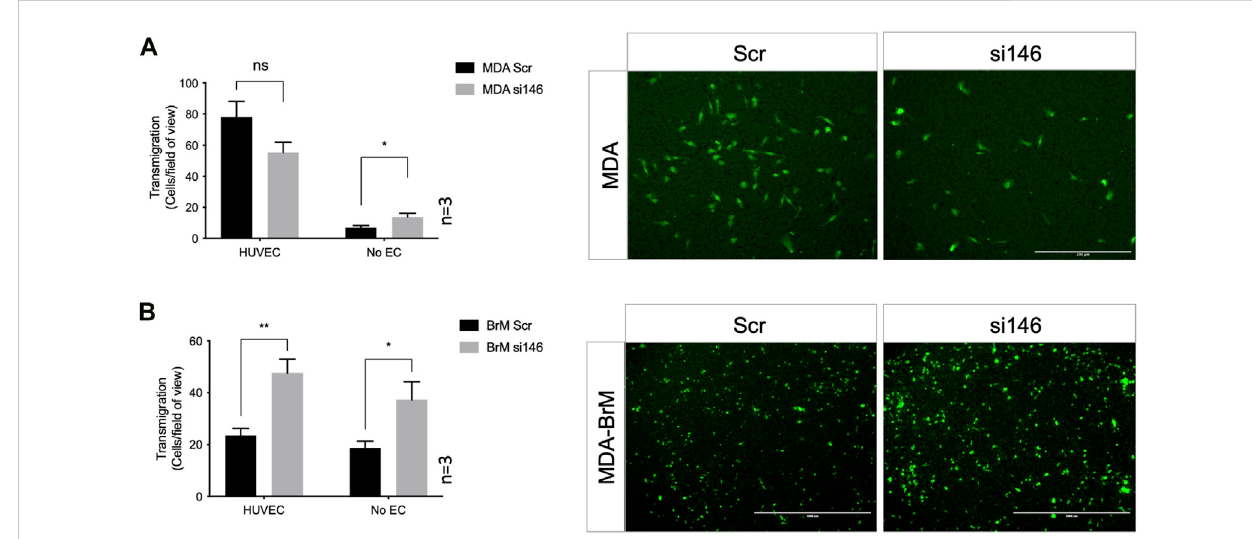
FIGURE 4 MCAM negatively regulates TEM of brain metastatic variant of breast cancer (A) MDA cells were transiently transfected with siRNA targeting CD146 (si146) or a scrambled control siRNA (Scr), CTG labelled, and seeded to the upper chamber of a Boyden transwell chamber in the presence of HUVEC monolayers.FortheNoECcondition,MDAcellswereseededtoemptytranswellsonly.CTGcellsthathadmigratedtotheundersideofthetranswell fi lter were imaged (as shown) and quanti fi ed 18 h post-seeding, as shown in the bar diagrams. Scale bar: 200 μ m. Data were derived from three independent experiments. Error bars indicate S.E.M. Analysis was performed using an unpaired T-test: * p < 0.05; ns, not signi fi cant. (B) As in (A) but using MDA-BrM cells. Scale bar: 1,000 μ m. Data were derived from three independent experiments. Error bars indicate S.E.M. Analysis was performed using an unpaired T-test; * p < 0.05; ** p <